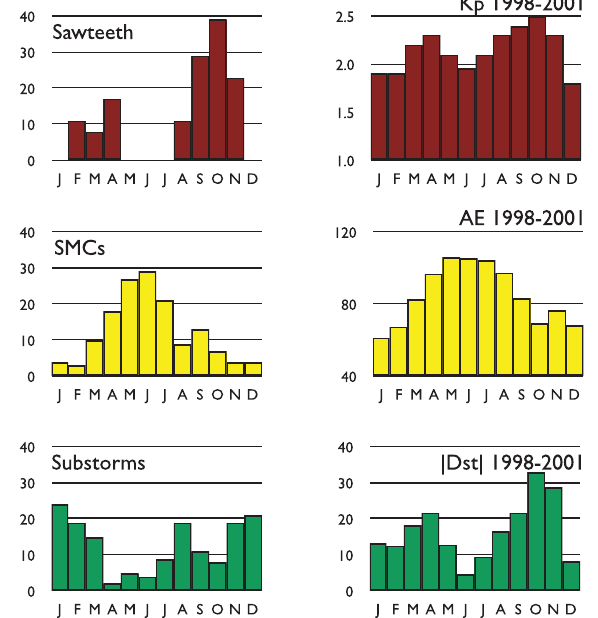
Fig. 2. Monthly distribution of the sawtooth events, SMCs and sub- storms (left column). The middle panel distribution represents the monthly occurrence of the SMC periods, while the top and bottom panel distributions show the monthly occurrence of the sawtooth events and isolated substorms, respectively. For a comparison, the right hand column contains the average monthly distribution of K p , AE and D st indices. The index data are constructed from daily av- erages of the time period